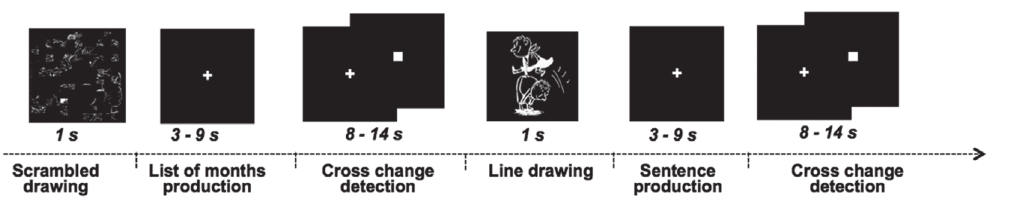
Figure 2. Illustration of the fMRI paradigm used for assessing language hemispheric lateralization. Subjects were presented during 1 sec white line drawing pictures on a black screen, which were either scrambled pieces randomly distributed (left part) or a cartoon depicting a scene (right part). Right after presentation of a picture, the subject had to covertly generate either the list of the months of the year (right part) or a sentence describing the cartoon (left part). During this generation period, participants had to fixate a white-cross displayed at the center of the screen and to press the pad with their index finger when they had finished. Note that a reference task followed each event, consisting in sustaining visual fixation on the cross and pressing the pad when the fixation cross was switched to a